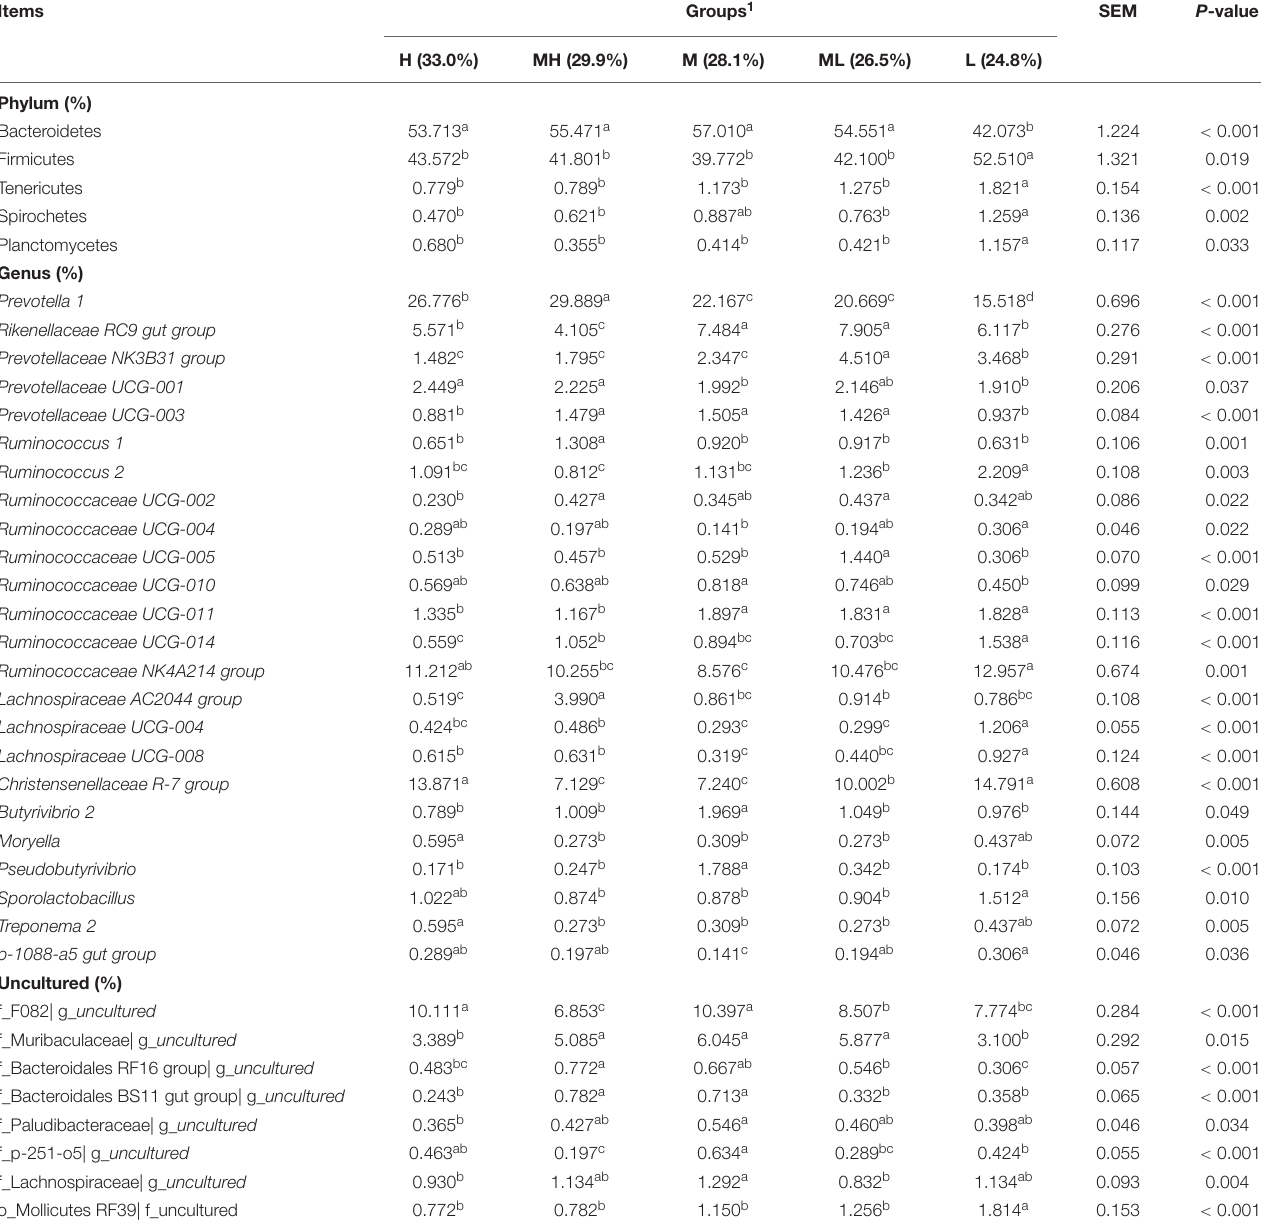
TABLE 6 | Effects of dietary peNDF 1 . 18 level on the relative abundance of rumen bacteria in goats. Items Groups 1